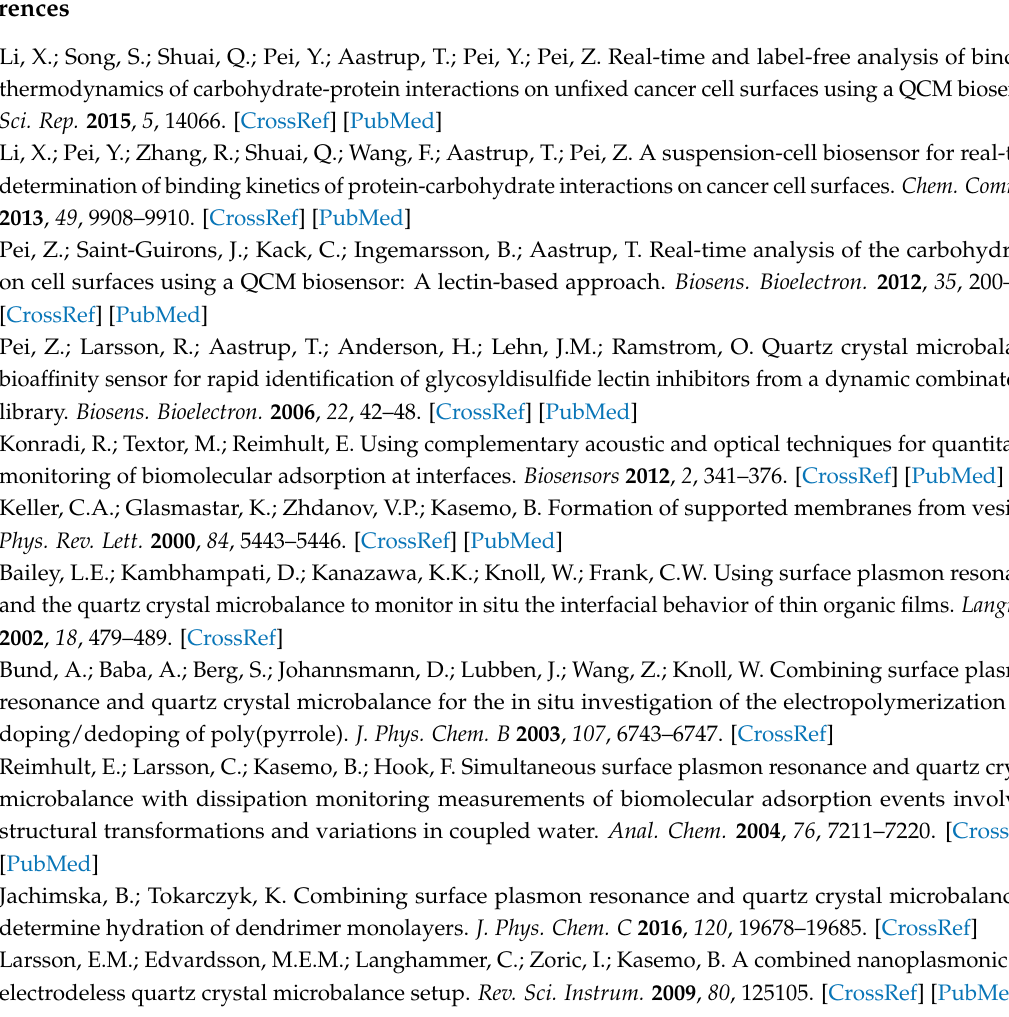
Figure S1: The short range term (1600 s) the stability of the quartz oscillator, Figure S2: The sensorgram of two injections of 100 µ g/mL biotinylated Con A on the avidin-FITC surface, Figure S3: The interactions between myoglobin (4 µ g/mL) and anti-myoglobin 7005 antibody without (red line) or in the presence of (black line) BSA (4 µ